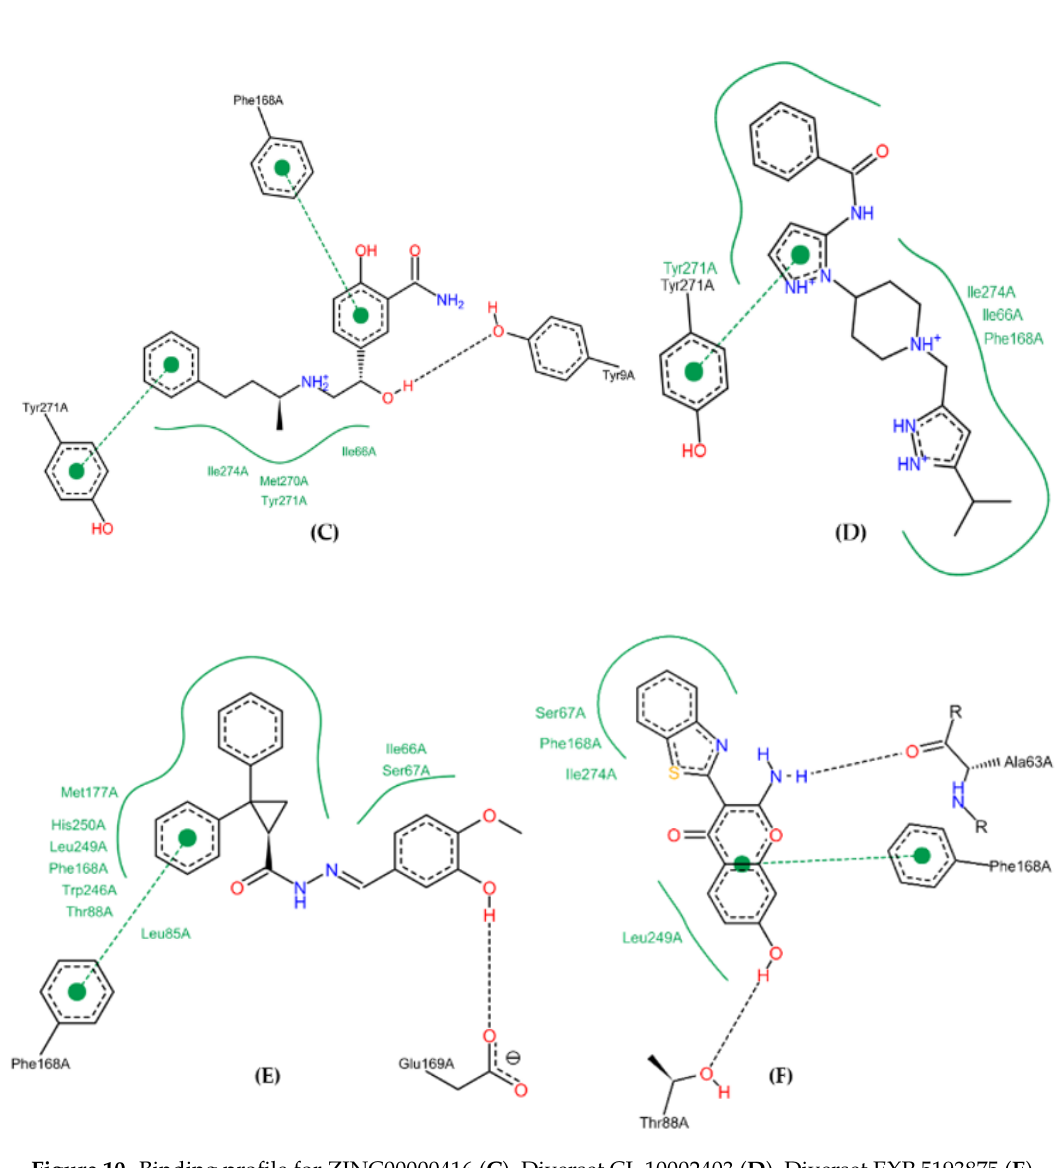
Figure 10. Binding profile for ZINC00000416 ( C ), Diverset CL 10002403 ( D ), Diverset EXP 5193875 ( E ) and Diverset EXP 6942649 ( F ) with the human adenosine A 2A AR receptor, Protein Data Bank (PDB ID 3QAK). Figure generated using the Poseview webserver.